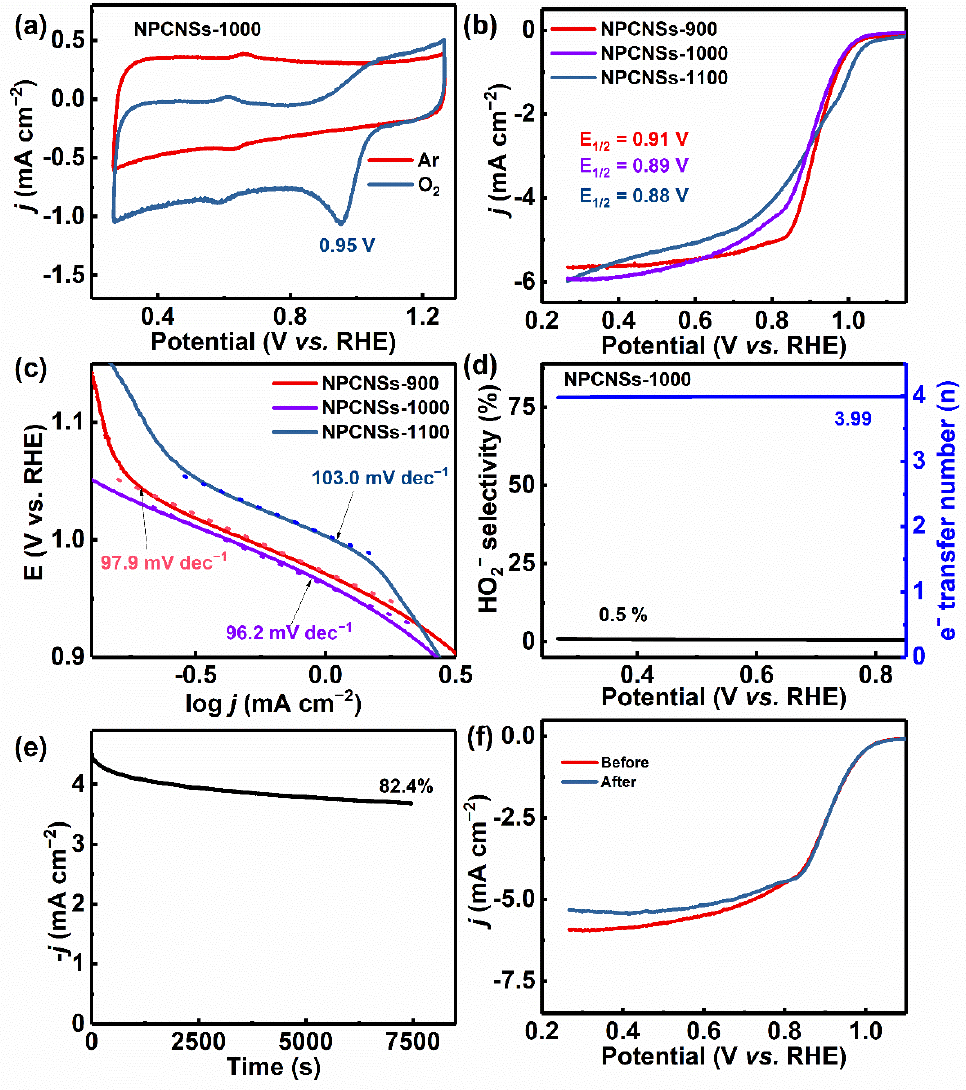
Figure 6. ( a ) CV curves of NPCNSs-1000 in the Ar-saturated and O 2 -saturated 0.1 M KOH solutions, ( b ) ORR LSV curves at 1600 rpm for and ( c ) ORR Tafel curves for NPCNSs- y ( y = 900, 1000, and 1100), ( d ) HO − yield and electron-transfer number ( n ), ( e ) CP curves at 0.8 V vs. RHE, and ( f ) LSV curves before and after CP test for NPCNSs-1000.